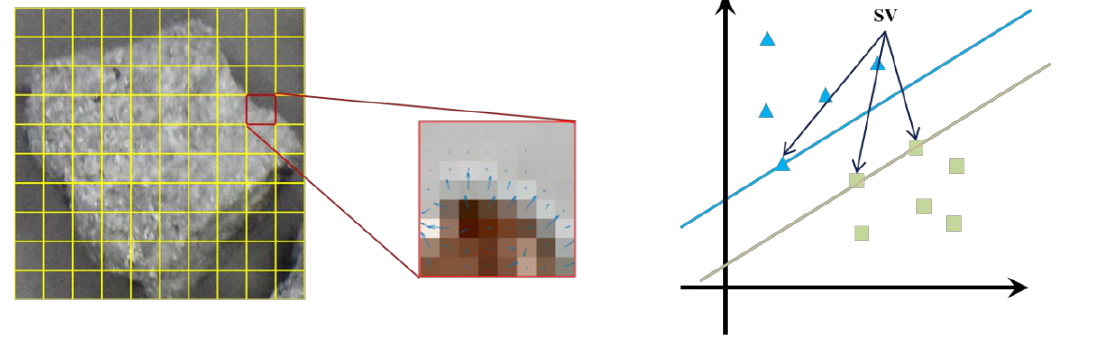
Figure 3. Principles of HOG and SVM.